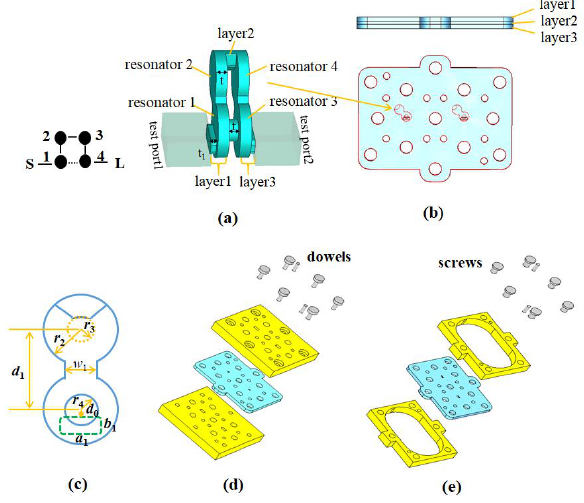
Figure 1. ( a ) The designed 4th BPF, ( b ) Top view and side view of the SU8 chip, ( c ) Main critical dimensions in microns are: r 1 = 1233.5, r 2 = 1188.9, r 3 = 401.4, r 4 = 498.2, w 1 = 1127.2, l a = 1631, l b = 736.2, d 0 = 91.9, d 1 = 2492.6, r g = 0.2, t = 500, t 1 = 250, ( d ) the design of pressing block Ⅰ , and ( e ) the design of pressing block Ⅱ and an exploded view when assembled. (The orange line is the label line and not the structural part).